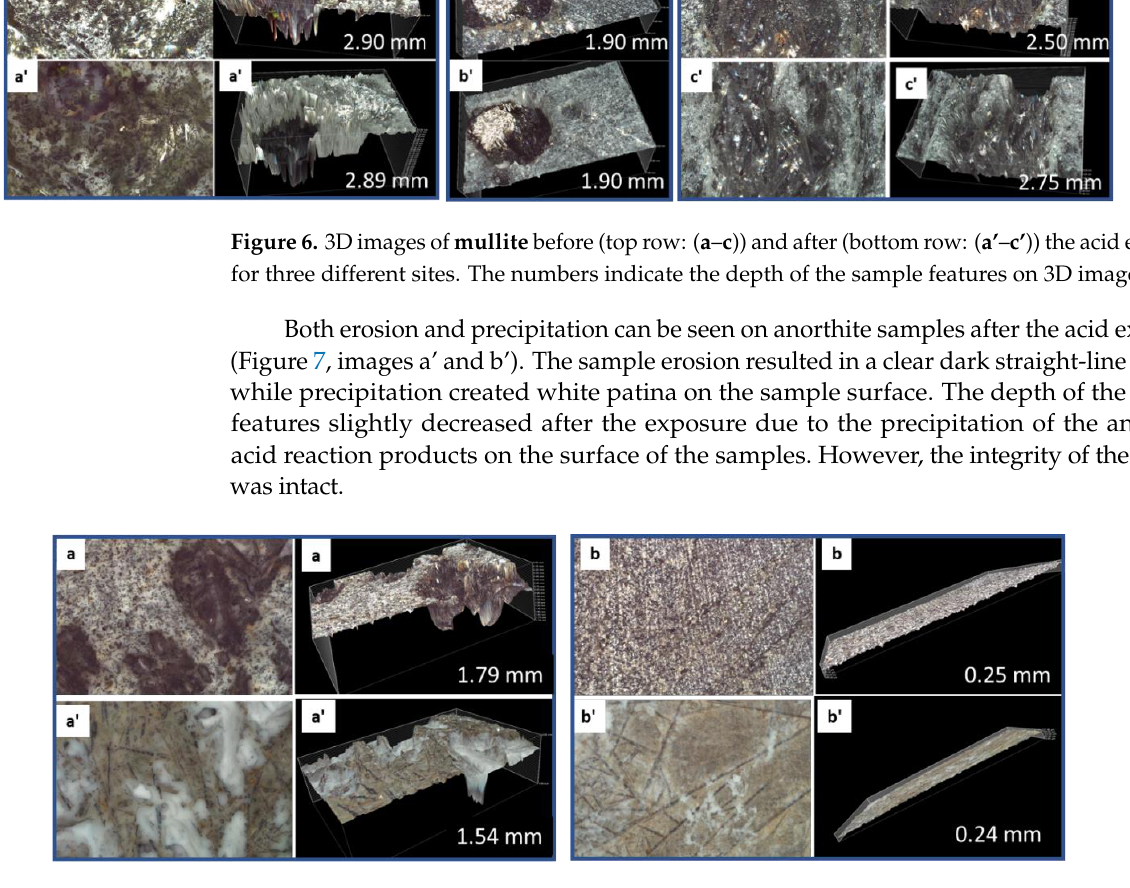
Figure 5. Appearance of samples after the 30-day, pH 1 sulfuric acid exposure.